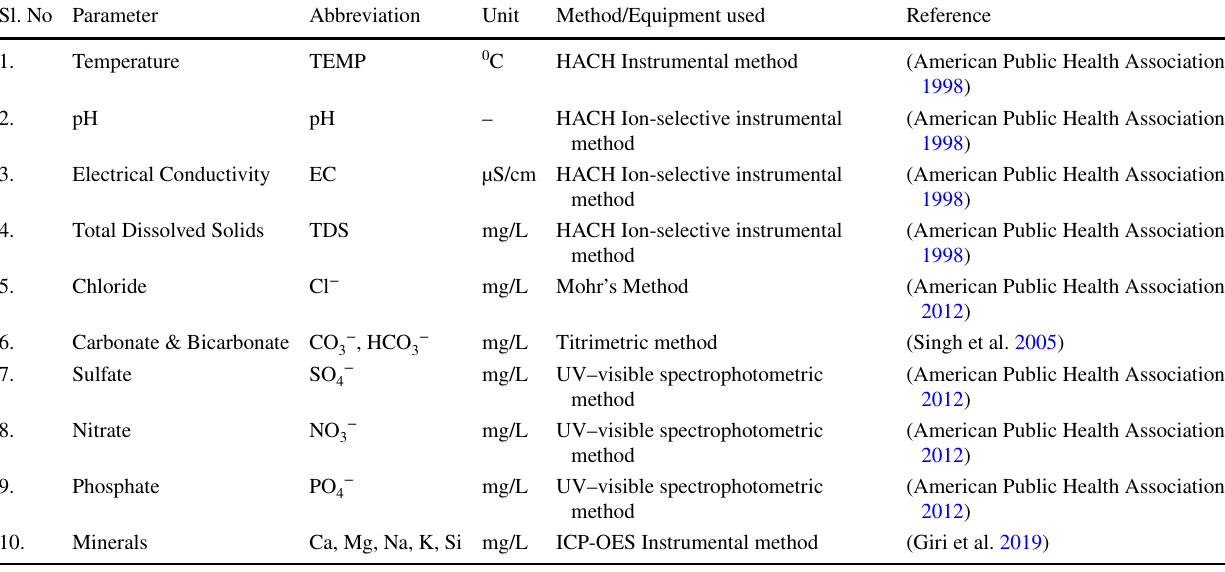
Table 2 Physicochemical and minerals parameters and their analytical techniques are undertaken (Adapted from (Giri et al. 2019)